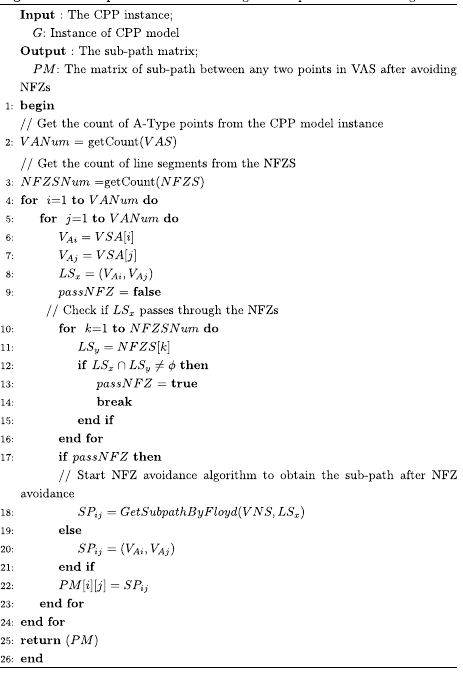
The Procedures for Solution As seen in the Algorithm 1, the main processing flow indicated